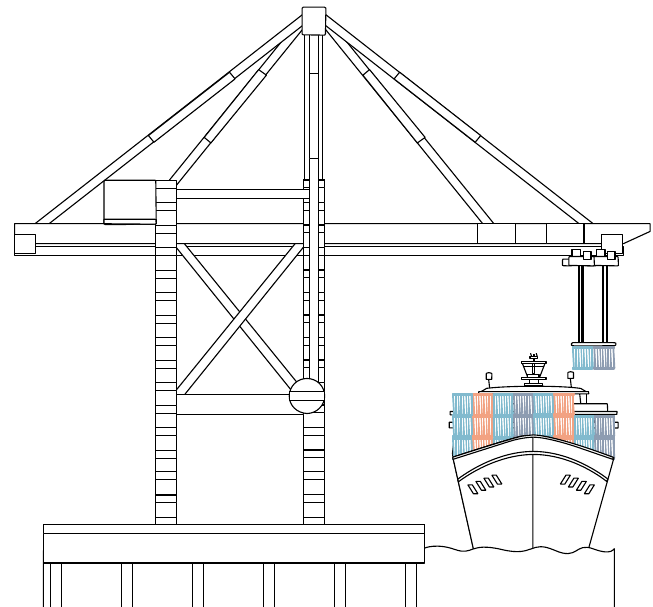
Figure 2. Operation of twin 40-foot QCs with the same tier.